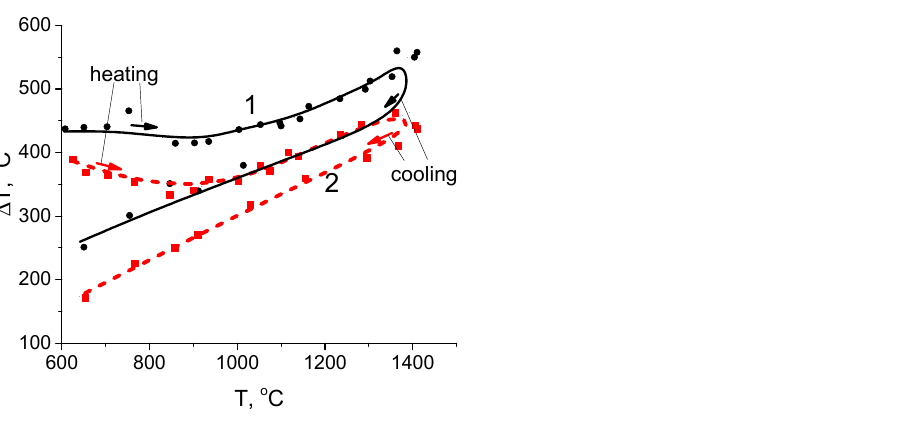
Figure 6. Dependence of the temperature drop ∆ T on the temperature of the irradiated surface: 1—equal thickness layers, 2—different thickness layers.